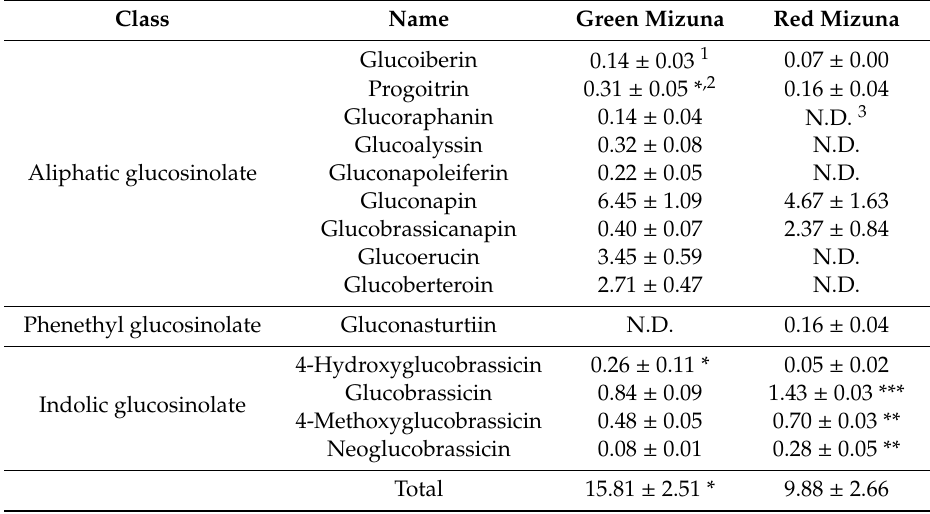
Table 2. Glucosinolate content in green and red kale ( µ mol / g dry weight).